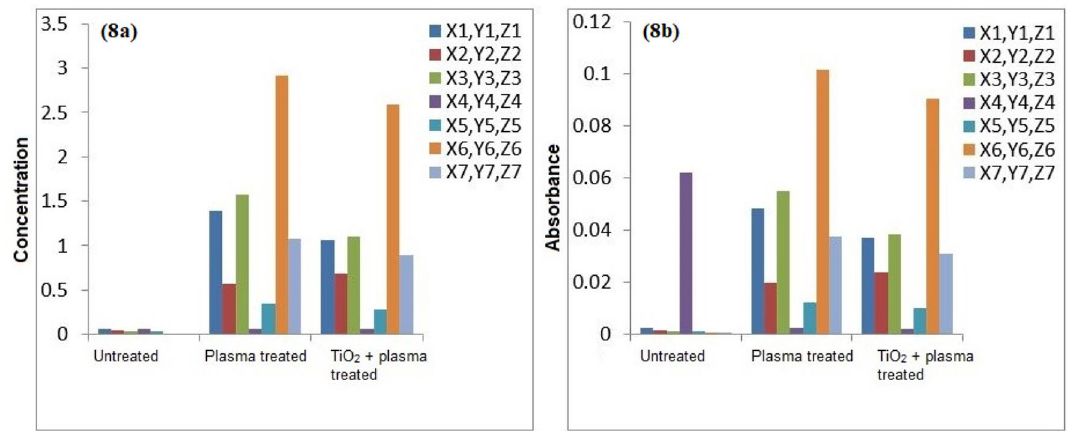
Figure 8. ( a ) Comparison of Cu concentration (mg/l), ( b ) Comparison of Cu absorbance (mg/l).